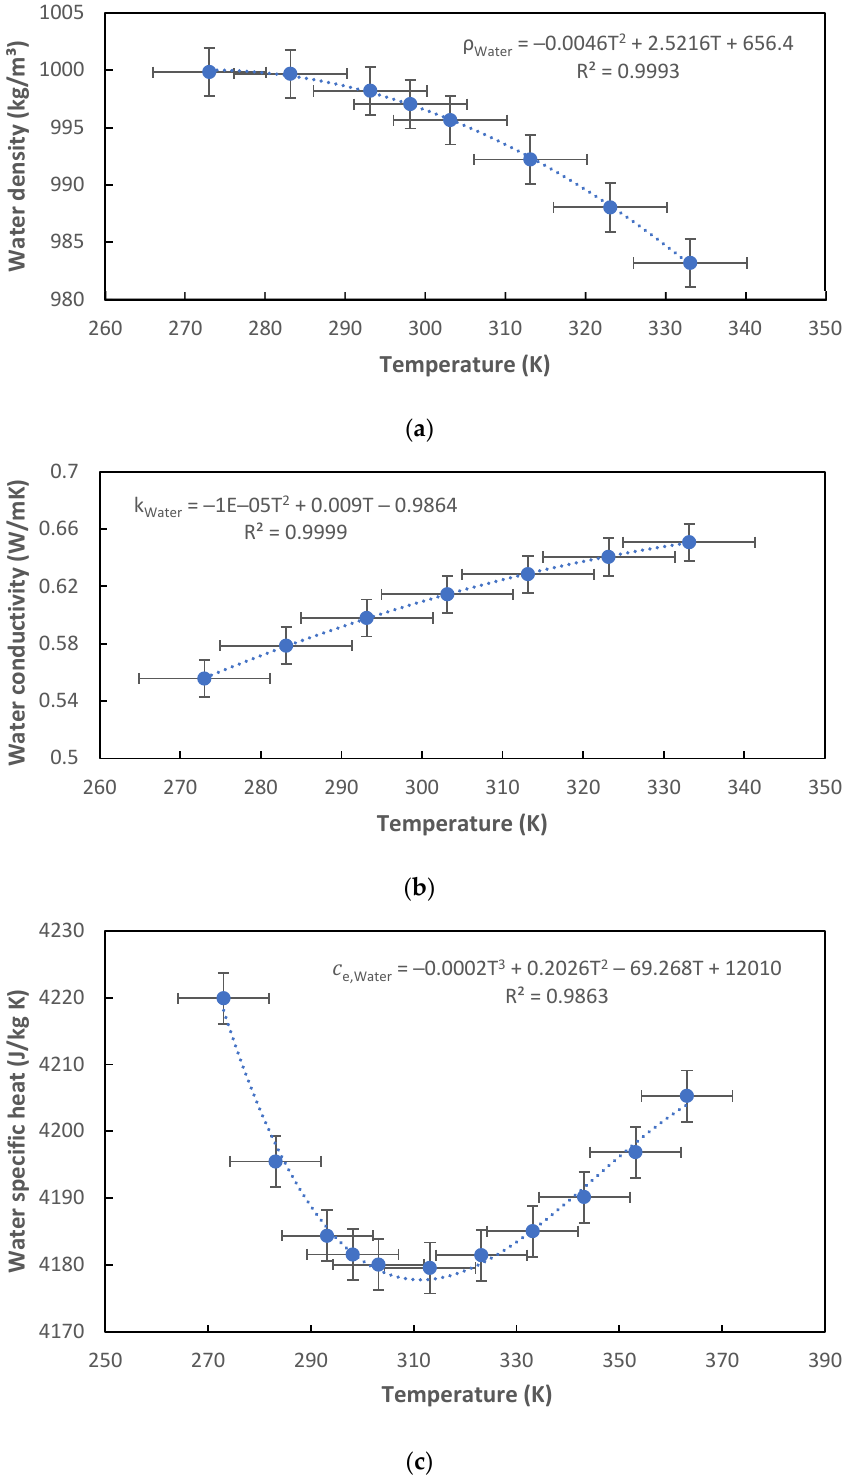
Figure 5. Water relation between material properties and temperature. ( a ) Density, ( b ) Thermal conductivity, and ( c ) Speci fi c heat.